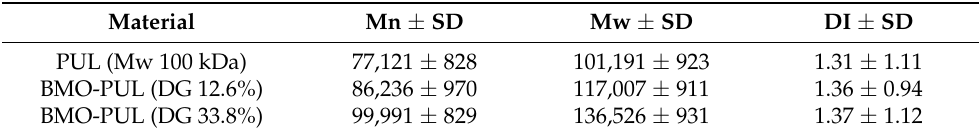
Table 2. Estimated Mw of the BMO-PUL derivatives ( n = 3; ±